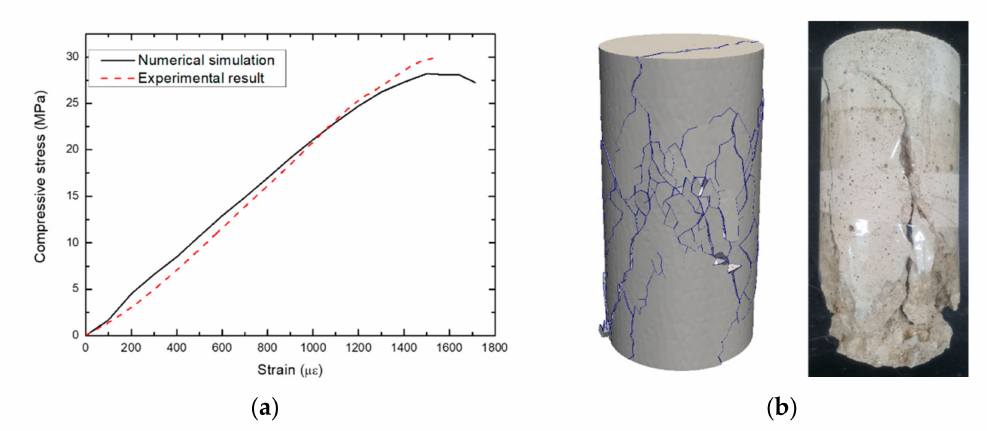
Figure 6. Comparison of FDEM numerical simulation and experiment of the UCS test of concrete under quasi-static loading: ( a ) plot of axial stress versus axial displacement and ( b ) final fracture pattern from the numerical simulation and experimental test.